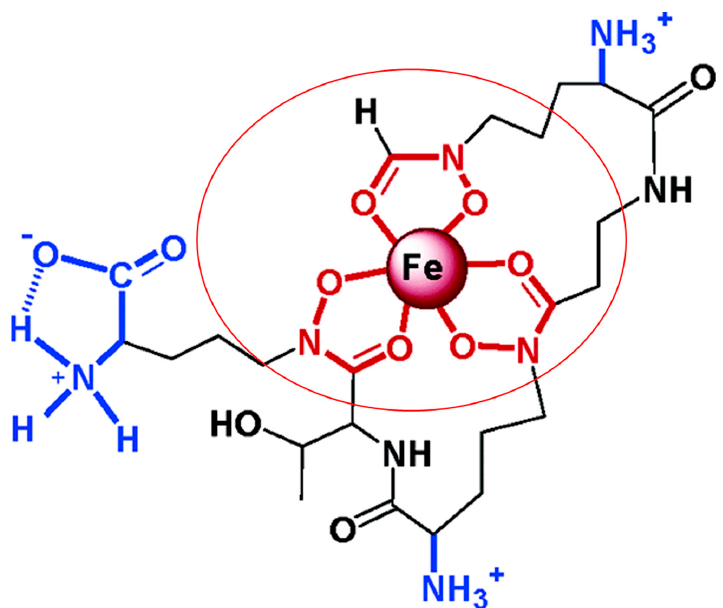
Figure 3. Structure of exochelin siderophore of M. smegmatis with its iron chelation proprieties. The iron-chelating residues of exochelin with their interaction with iron molecule is shown in red circle (adapted from [29]).